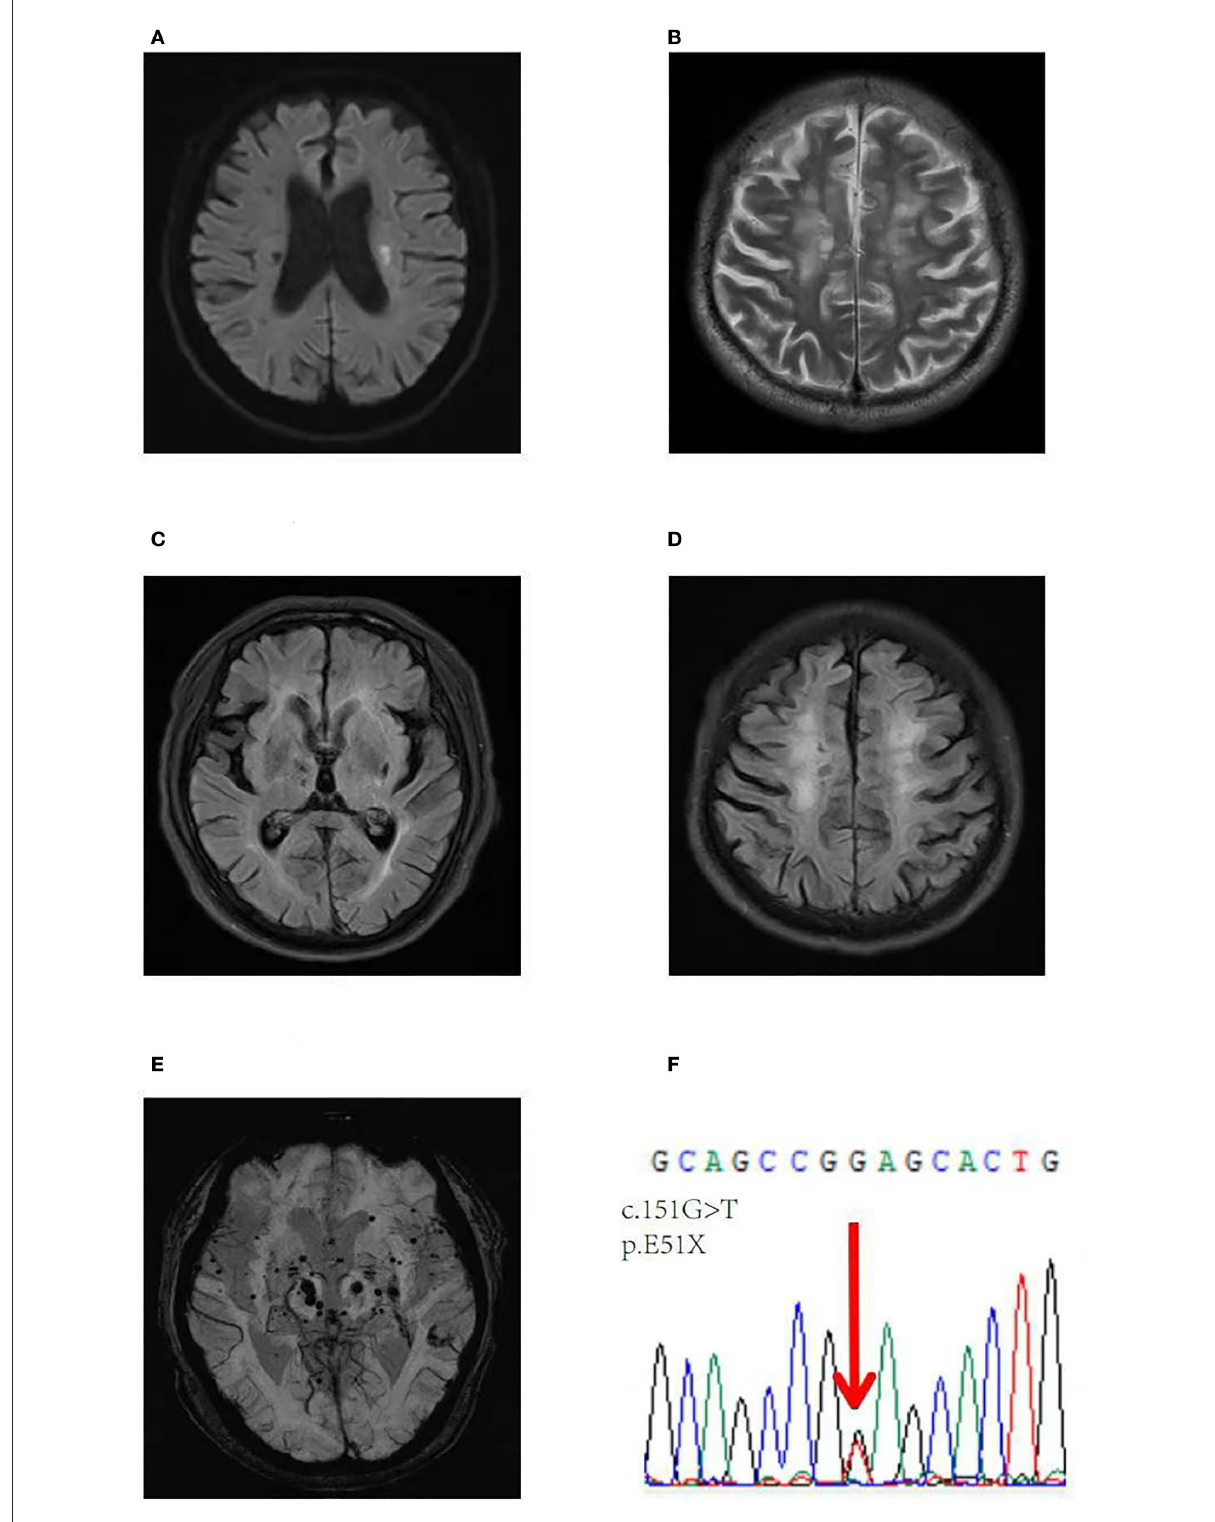
FIGURE2 Brain axial images of the second patient. A DWI image showing an acute infarct in the left corona radiata (A) , axial T2-weighted (B) and FLAIR axial images (C, D) showing diffuse WMLs and brain atrophy, Fazekas scale score 3, and an SWI image showing chronic microbleeds in lobar regions and the deep white matter (E) . (F) Validation of a heterozygous G to T mutation at position 151 (NM_002775: c.151G > T) in exon 1 of the HTRA1 gene, resulting in a stop codon at 51